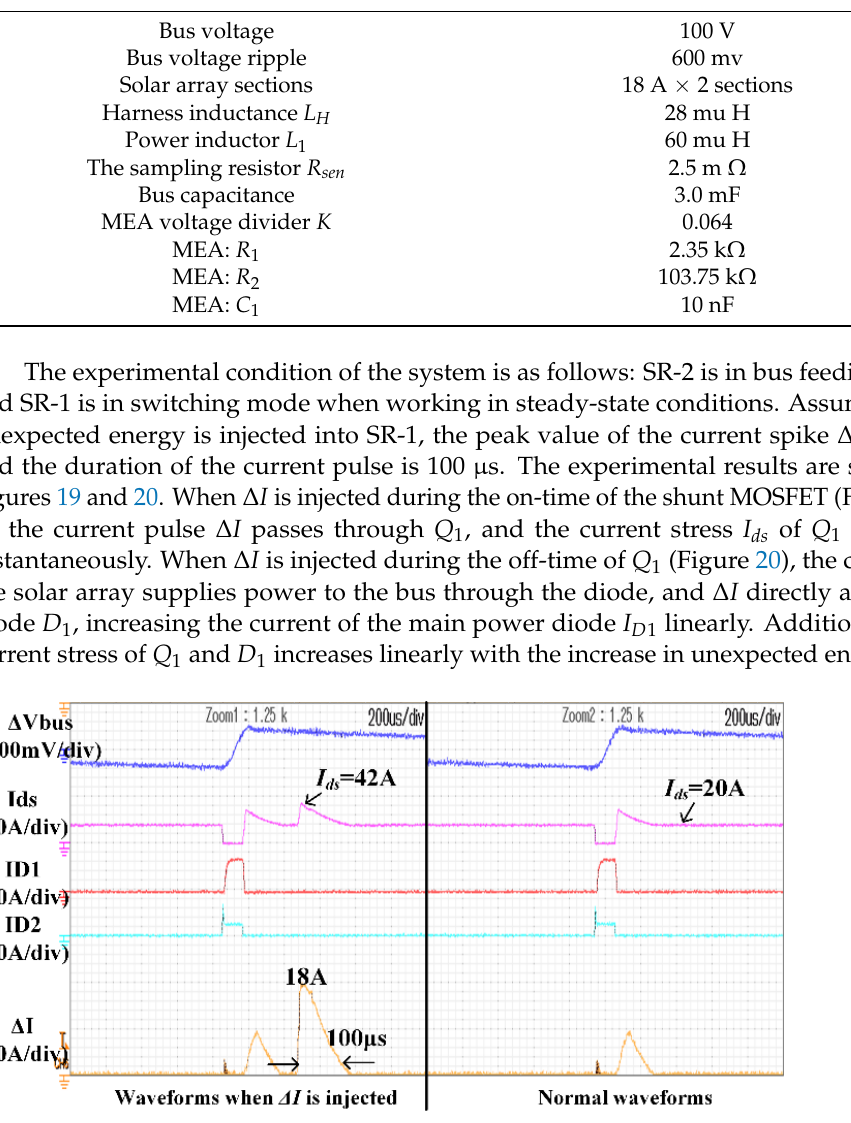
Figure 20. Δ I is injected during the off ‐ time of MOSFET.